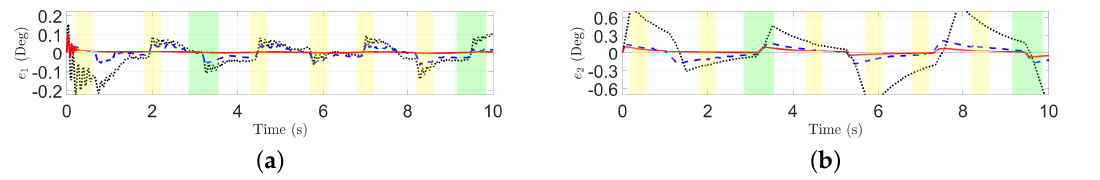
Figure 7. Comparison of the tracking errors of time-delayed control (TDC) approach (dotted line), adaptive sliding-mode control (ASMC) approach (dotted dashed line), and the proposed SS-ASMC approach (solid line): ( a ) Joint 1. ( b ) Joint